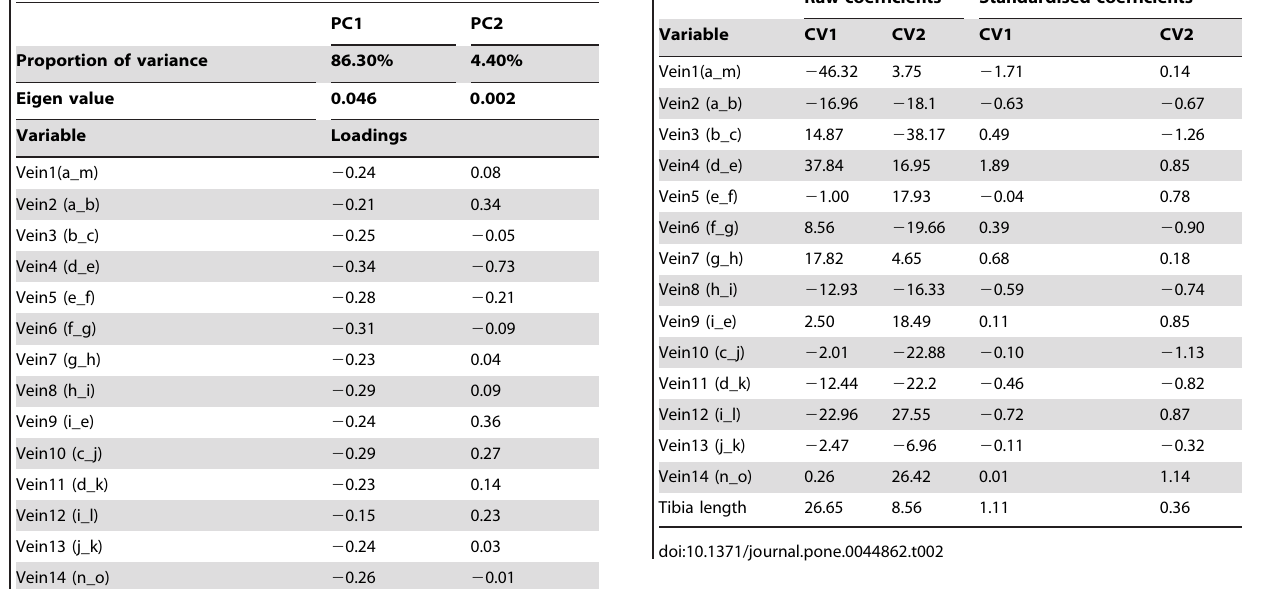
Table 1. Eigen values and coefficients (loadings) of the first two principal components (PC1 and PC2) for the log- transformed wing measurements data of the fruit fly populations.